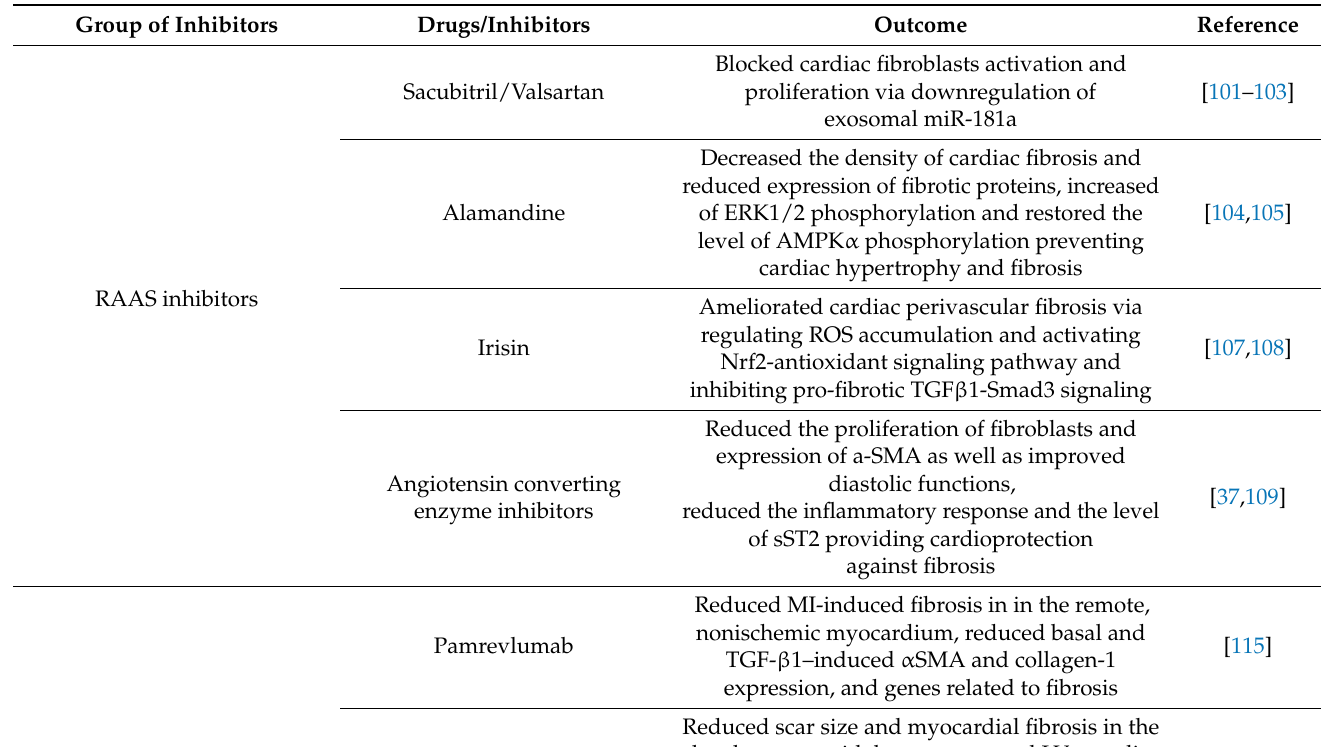
Table 3. The anti-fibrotic